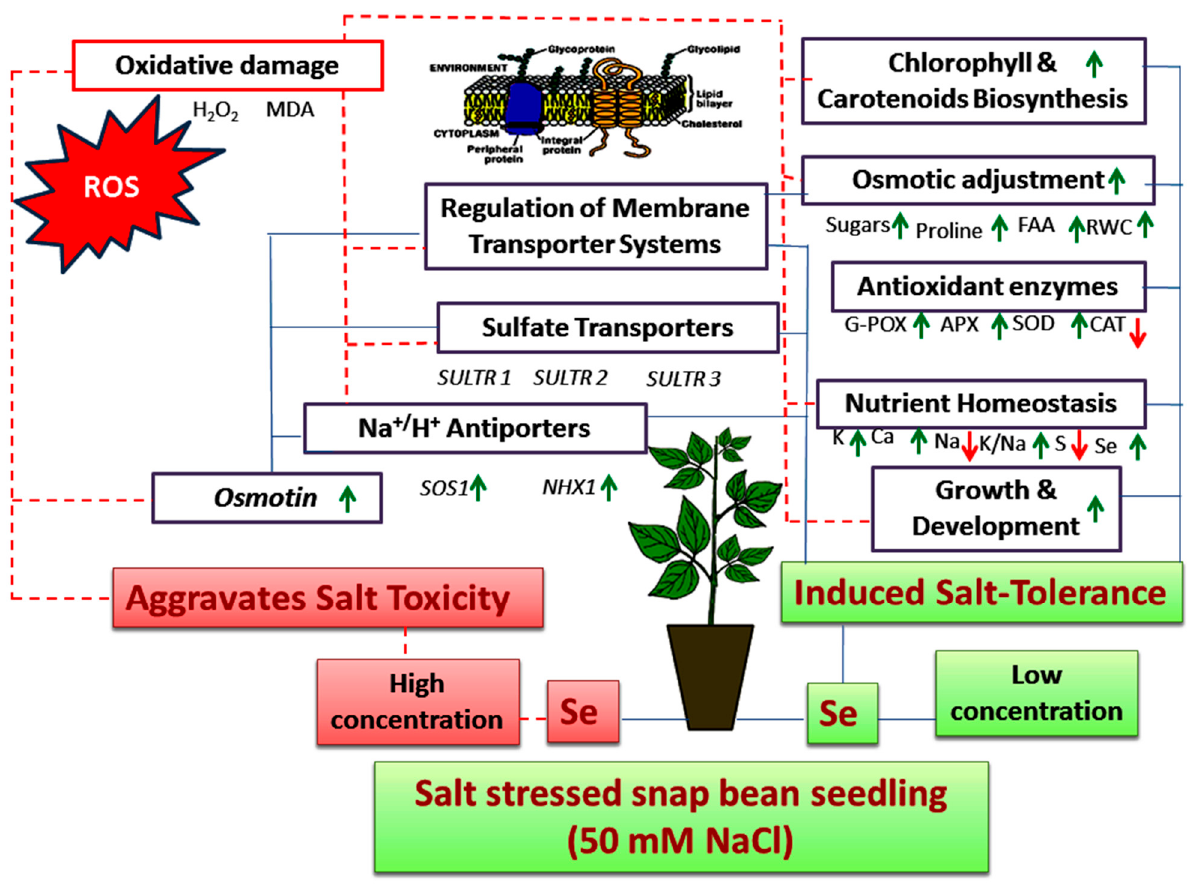
Figure 9. Simplified model for the suggested effects of applied Se on snap bean plants grown under salinity stress. RWC, relative water content; MDA, malondialdehyde; FAA, free amino acids; G-POX, Guaiacol peroxidases; CAT, catalase; APX; ascorbate peroxidase; SOD, superoxide dismutase; blue solid lines indicate the positive effects of applied Se at low concentration; red dotted lines indicate the negative effects of applied Se at high level; green up arrow, increase; red down arrow.